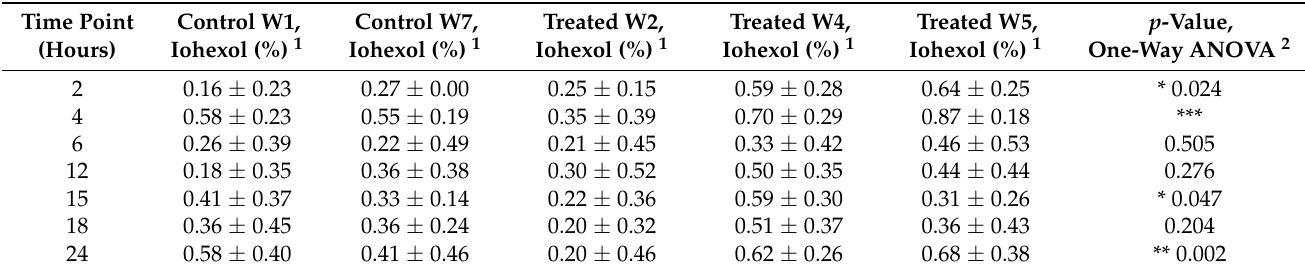
Table 1. Urinary excretion of iohexol (%) in control and treated mice measured seven times over a 24 h period after iohexol oral administration.